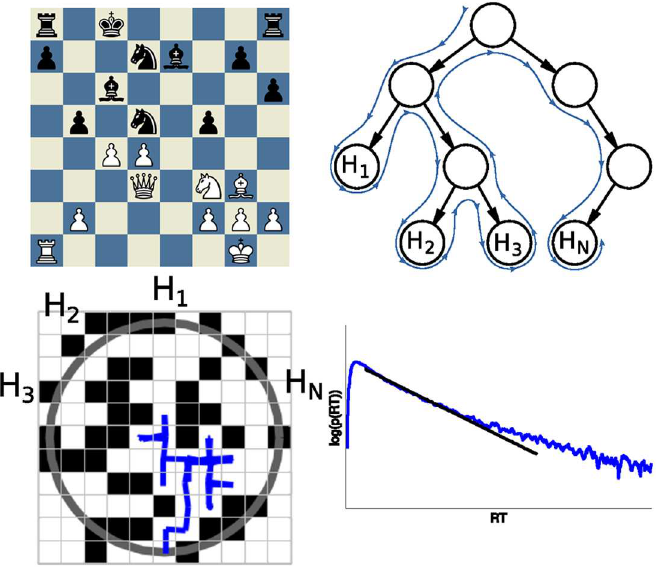
Fig 1. a) Chess board example of the game between Gary Kasparov and Deep Blue on May 11th, 1997—the winning game of machines against humans. b) Decision tree for current position and hypothetical walk through it until decision is made. c) Particle moving in a 2-D mesh with obstacles resembling the tree search heuristic. d) RT distribution with super-exponential